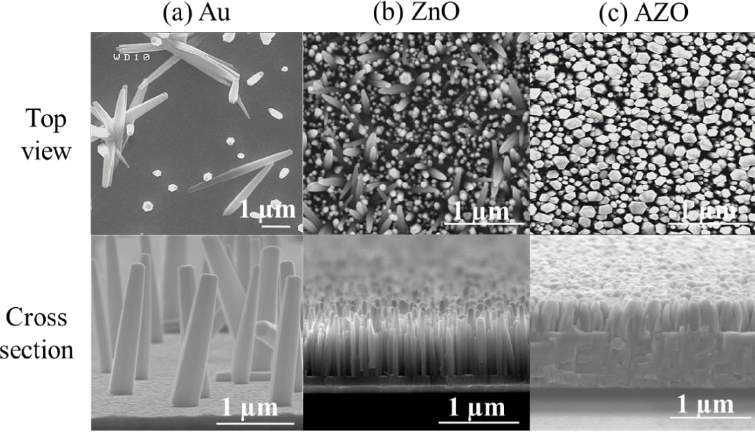
Figure 6. SEM images of ZnO NWs grown on ( a ) Au; ( b ) ZnO and ( c ) AZO seed layers. The ZnO NWs on the Au, ZnO and AZO seed layers had an average density of 0.6, 35.4 and